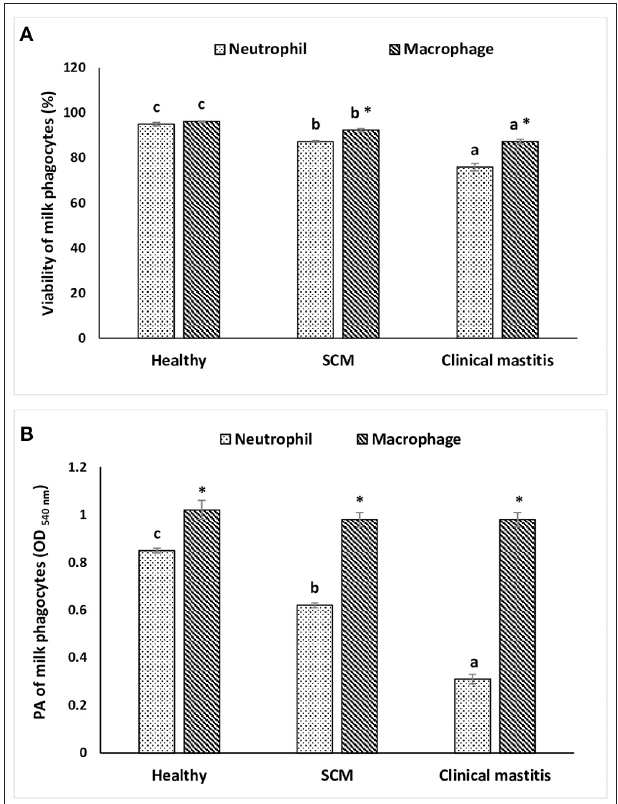
FIGURE 4 | The viability (A) and in vitro phagocytic activity (B) of milk phagocytes in healthy, subclinical mastitis (SCM), and clinical mastitis Sahiwal cows. Data were expressed as mean ± SEM. Means statistically ( p < 0.05) different between the groups are shown with superscript letters (a–c). *Statistical difference ( p < 0.05) within the same